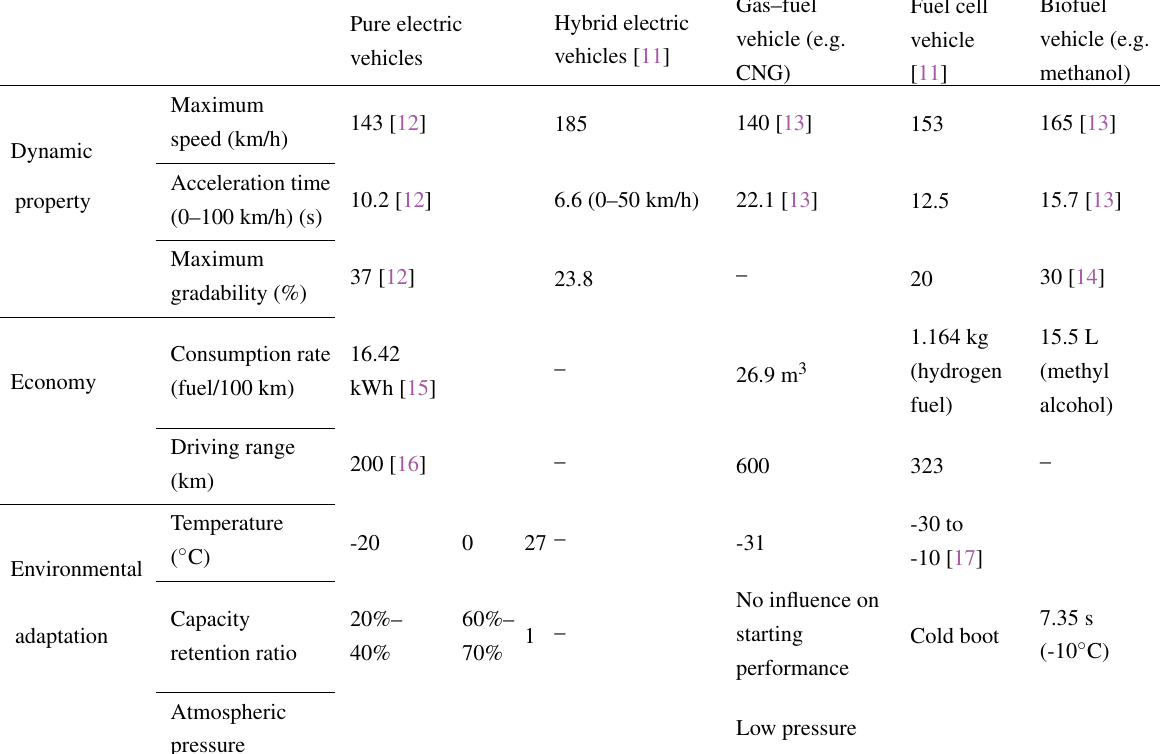
Table 1 The indicators of vehicles with different power